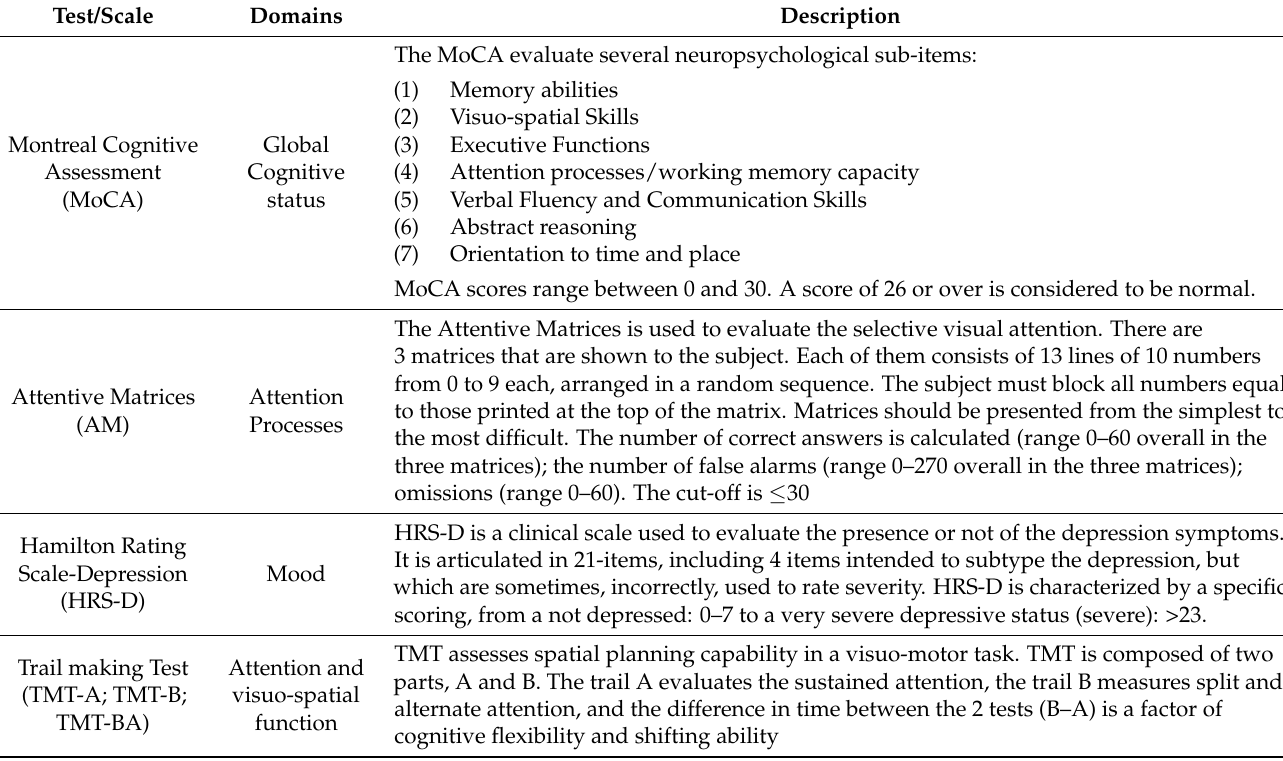
Table 2. Description of cognitive assessment tools used in traumatic brain injury